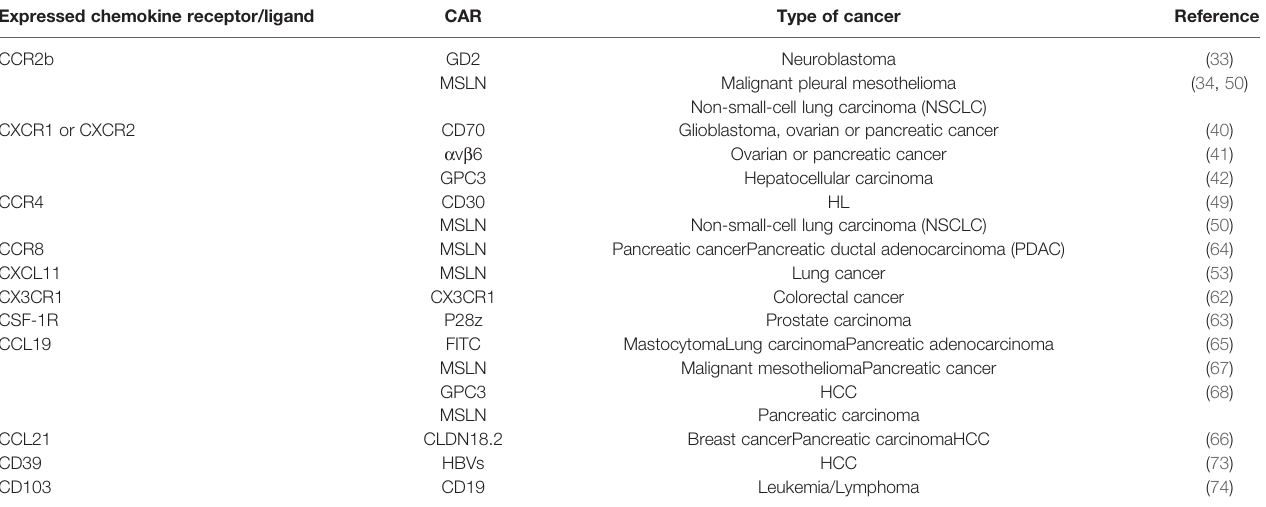
TABLE 1 | Summary of preclinical studies on chemokine receptors/ligands or homing molecules expressing CAR-T cells. Expressed chemokine receptor/ligand